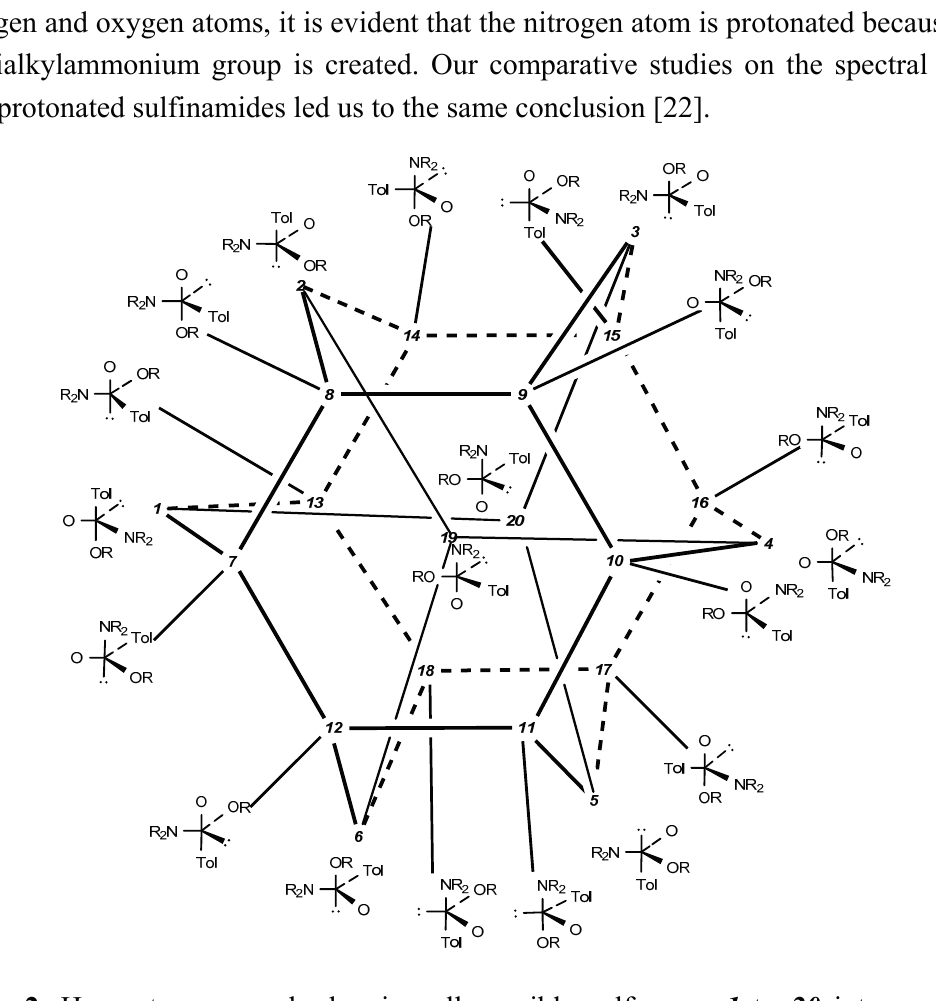
Figure 2. Hexaasterane graph showing all possible sulfuranes 1 to 20 internconnected by pseudorotations (for the sake of clarity hydrogens on the nitrogen and oxygen atoms are